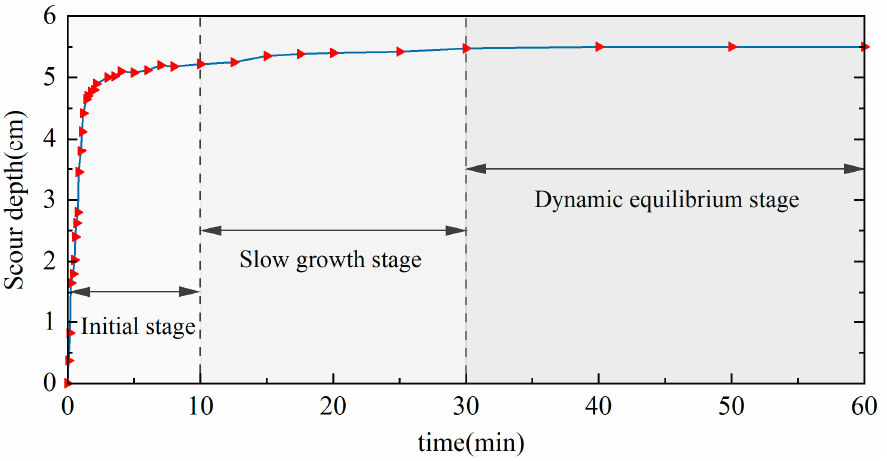
Figure 8. Development of local scour depth around a single pier without a permeable collar.